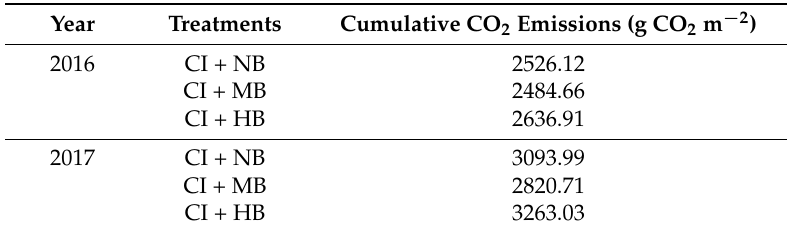
Table 3. Cumulative CO 2 emissions under different biochar application rates.